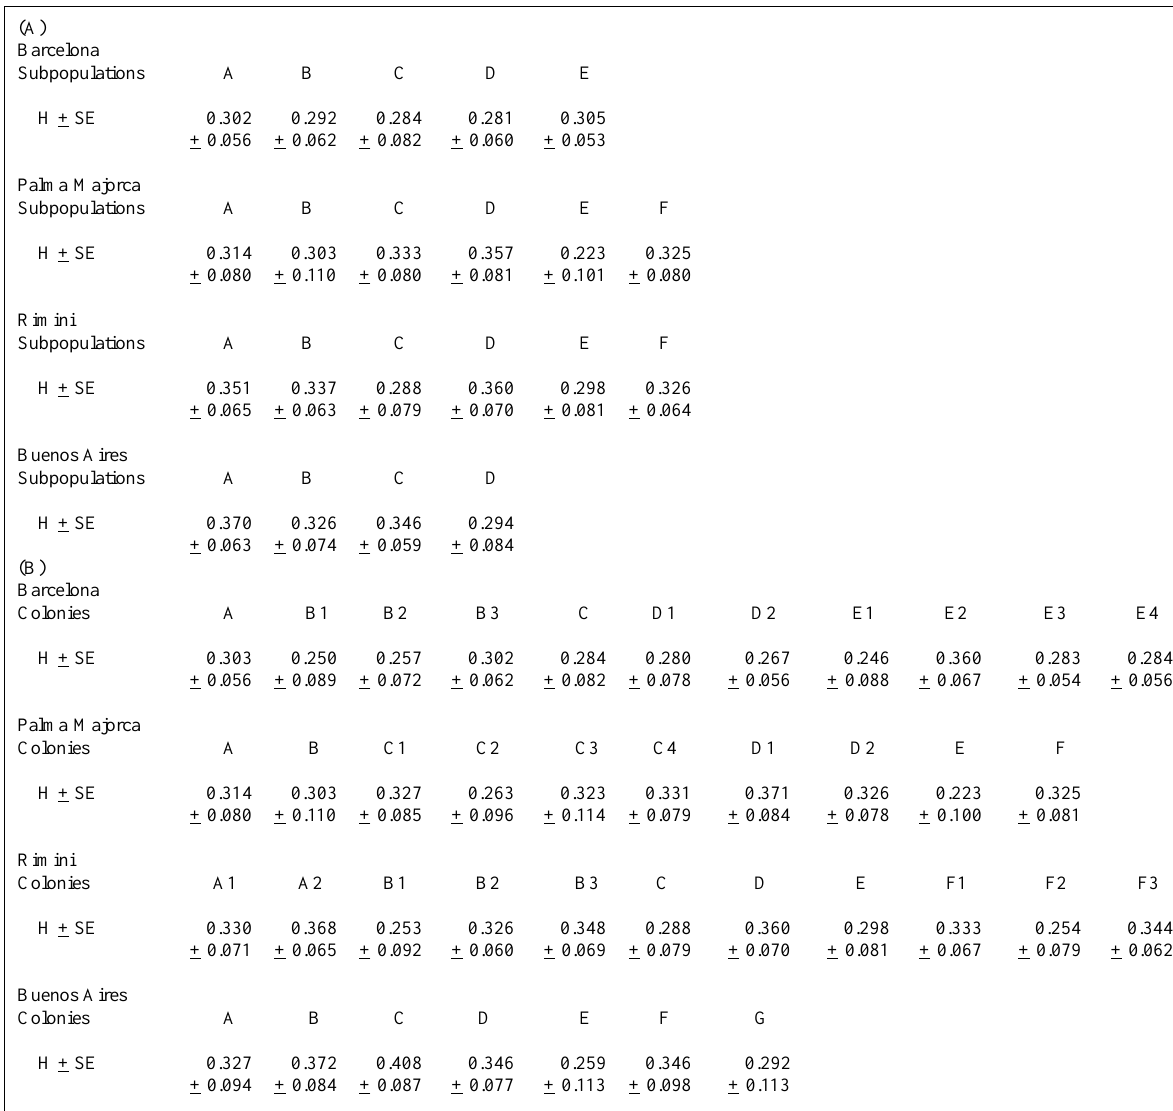
Table IV - (A) Expected mean heterozygosity (H) and standard error (SE) for seven morphological loci at subpopulation level in the four cat populations studied. (B) Expected mean heterozygosity (H) and standard error (SE) for seven morphological loci at colony level in the four cat populations